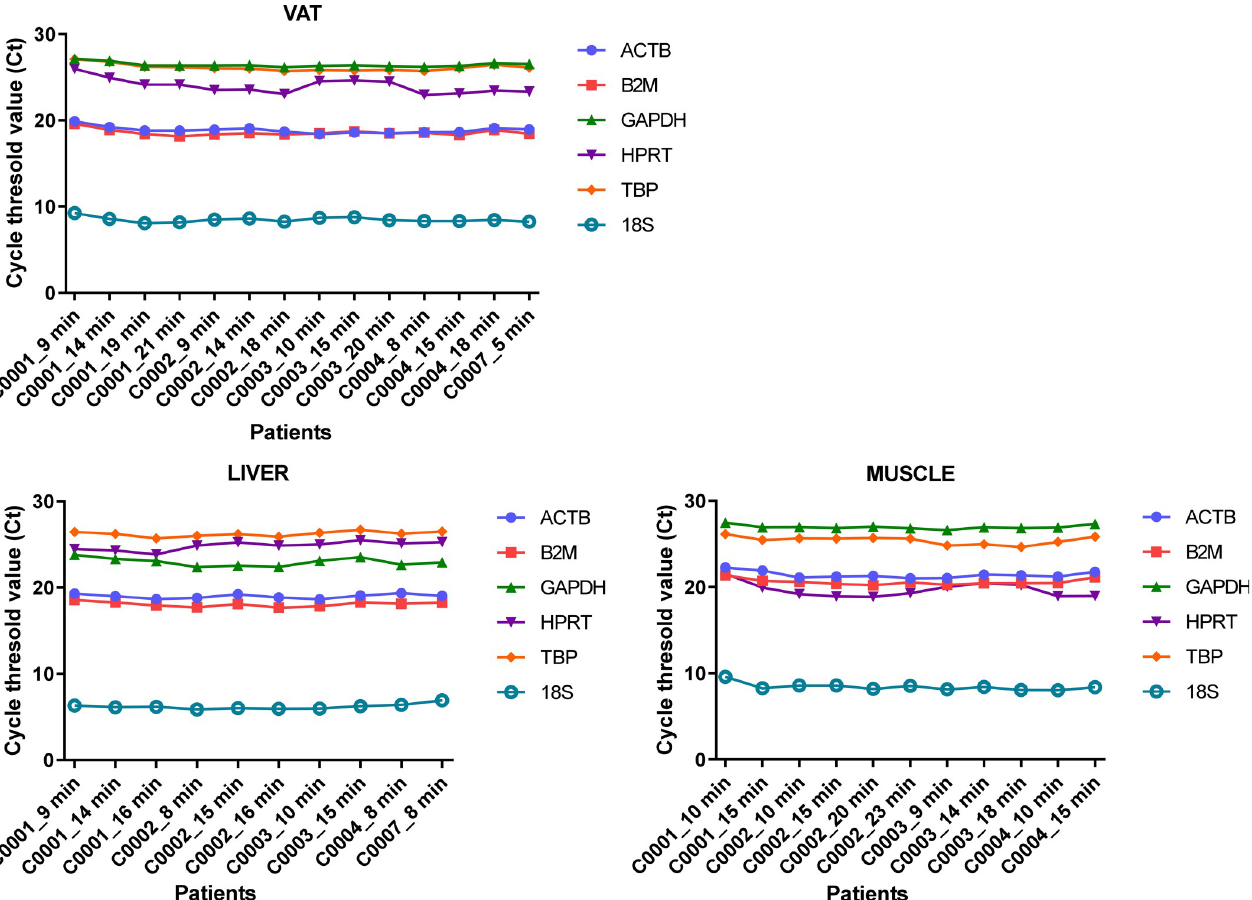
Fig 4. Cycle threshold (Ct) values of six housekeeping genes according to handling time for tissue preparation for the first five patients. RNA was used to perform a RT–qPCR in order to amplify six housekeeping genes (ACTB, B2M, GAPDH, HPRT, TBP, 18S). Ct values were shown for the genes according the type of tissue samples resected from the first five patients and the handling time between tissue resection and snap–freezing. VAT, visceral adipose